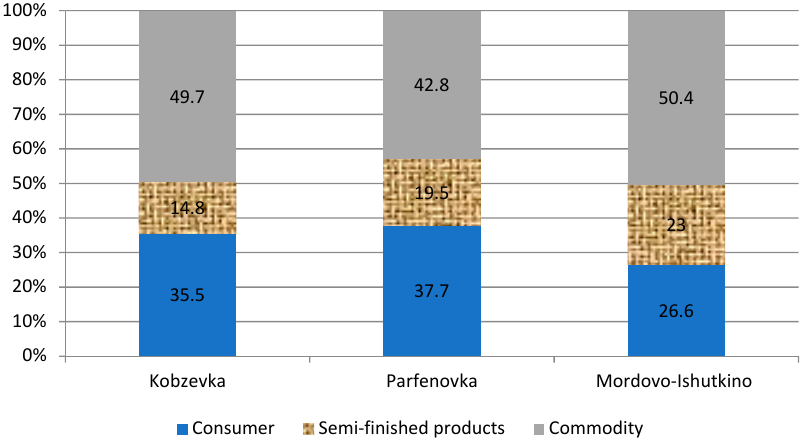
Figure 3. Comparison of private households by the marketability level in 2014–2018.